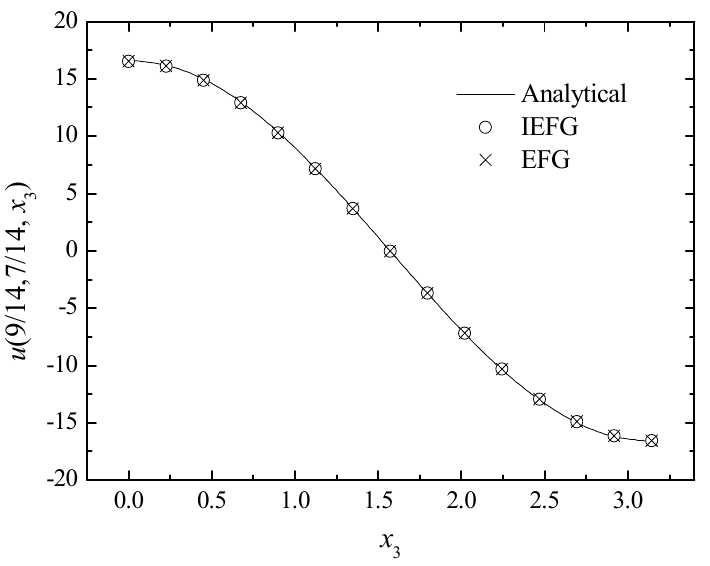
Figure 5. The comparison of the numerical and analytical solutions of the two methods along the x 3 -axis.